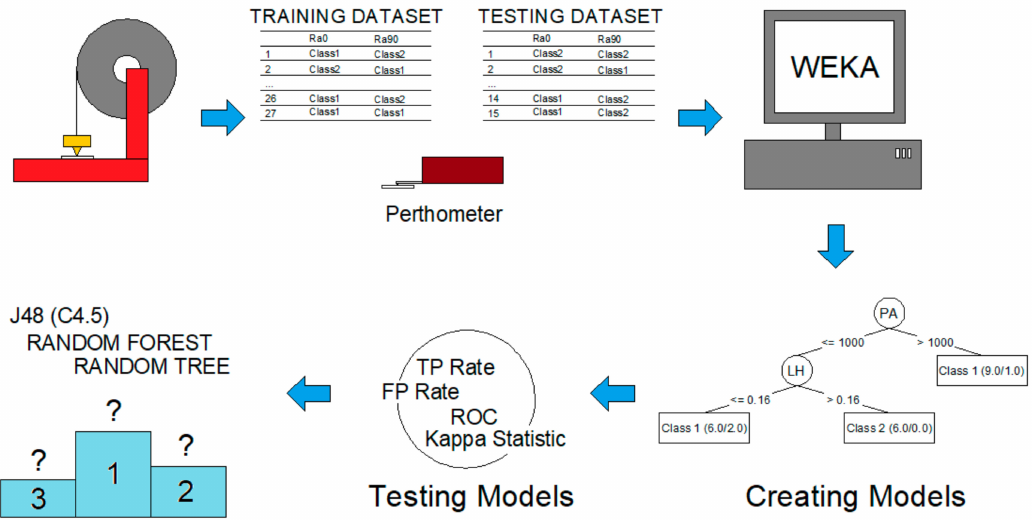
Figure 1. Di ff erent stages that compose the methodology followed in the present work: 3D printing, surface roughness measurements, data mining, models generation, models testing, and comparison between